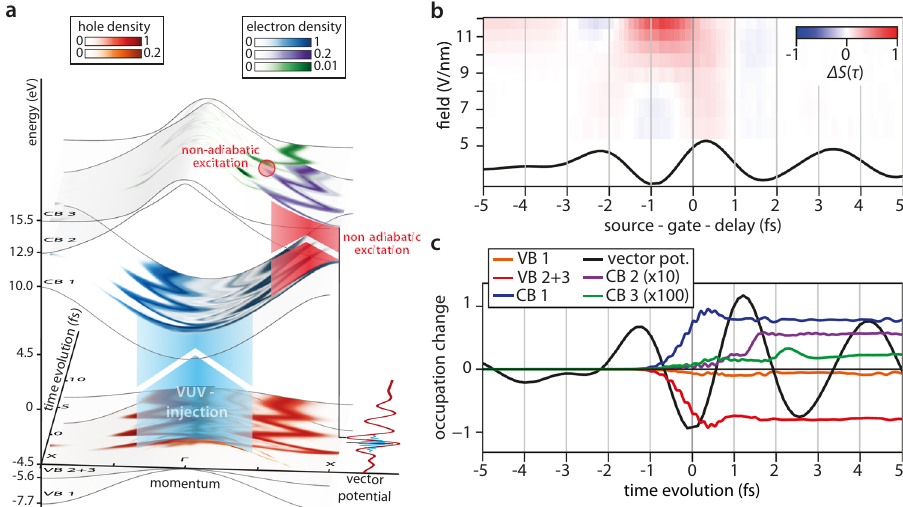
Fig. 4 Wavepacket modeling of linear petahertz photoconductive sampling (LPPS) using optical Bloch equations along the Γ − X direction in LiF. a Crystal-momentum-resolved temporal evolution of the conduction band electron and valence band hole populations when the VUV source pulse (light blue, central photon energy 2.6 eV above the bandgap) precedes the maximum of the gate pulse vector potential (red) by one gate fi eld half-cycle (source- gate-delay = − 1 fs in Figs. 3b, c, 4b). The origin of the time evolution axis corresponds to the maximum of the source pulse, i.e., the moment of carrier injection into the fi rst conduction band. The gate fi eld strength applied in this simulation was 8.7 V/nm. Interband transitions are marked by the light blue and red areas. After the interaction of the excited carriers with the gate pulse, occupation in multiple valence and conduction bands contributes to the asymptotic current. Non-coupling bands are omitted and populations are normalized to the maximum electron population for clarity. b Simulated LPPS signal deviation Δ S ( τ ) as a function of source-gate-delay and gate intensity for the experimental gate pulse vector potential (black). As in the experiment, the largest deviations are found in the cycle before the gate-pulse maximum. The amplitude of the intraband deviation around 0 fs source-gate-delay caused by conduction band non-parabolicity is only ~4% of the maximum deviation and is smaller than the experimental uncertainty. c Time-dependent occupation of the LiF valence and conduction bands (colored lines). First, CB1 population is generated by the VUV source pulse. Then, delayed population of CB2 and CB3 is induced by Landau – Zener transitions driven by the gate fi eld. The source-gate-delay and time evolution axis origin are the same as in panel ( a ). In all panels, the gate-induced linear polarization is